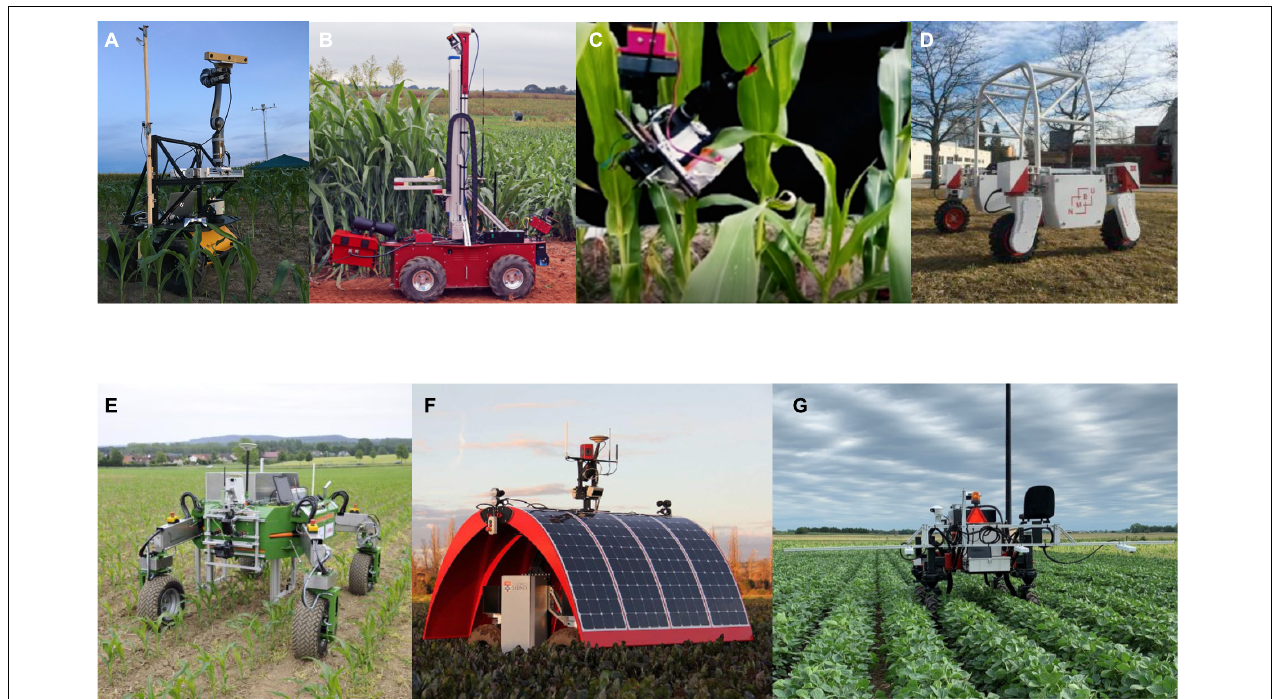
FIGURE 3 | Plant phenotyping systems for outdoor environment: (A) Vinobot: robotic system including six DOF robotic manipulator and a 3D imaging sensor mounting on a mobile platform to measure plant height and LAI (Shafiekhani et al., 2017), (B) Robotanist: UGV-based robotic system equipped with a three DOF robotic manipulator and a force gauge for stalk strength measurement (Mueller-Sim et al., 2017), (C) A robotic system to slide LeafSpec across entire leaf to collect its hyperspectral images (Chen et al., 2021), (D) Thorvald II: VIS/NIR multispectral camera mounted on a mobile robot to measure NDVI (Grimstad and From, 2017), (E) BoniRob: autonomous robot platform using spectral imaging and 3D TOF cameras to measure plant height, stem thickness, biomass, and spectral reflection (Biber et al., 2012), (F) Ladybird: ground-based system consisted of a hyperspectral camera, a stereo camera, a thermal camera, and LIDAR to measure crop height, crop closure, and NDVI (Underwood et al., 2017), and (G) Flex-Ro: high-throughput plant phenotyping system equipped with a passive fiber optic, a RGB camera, an ultrasonic distance sensor, and an infrared radiometer for the measurement of NDVI, canopy coverage, and canopy height (Murman,